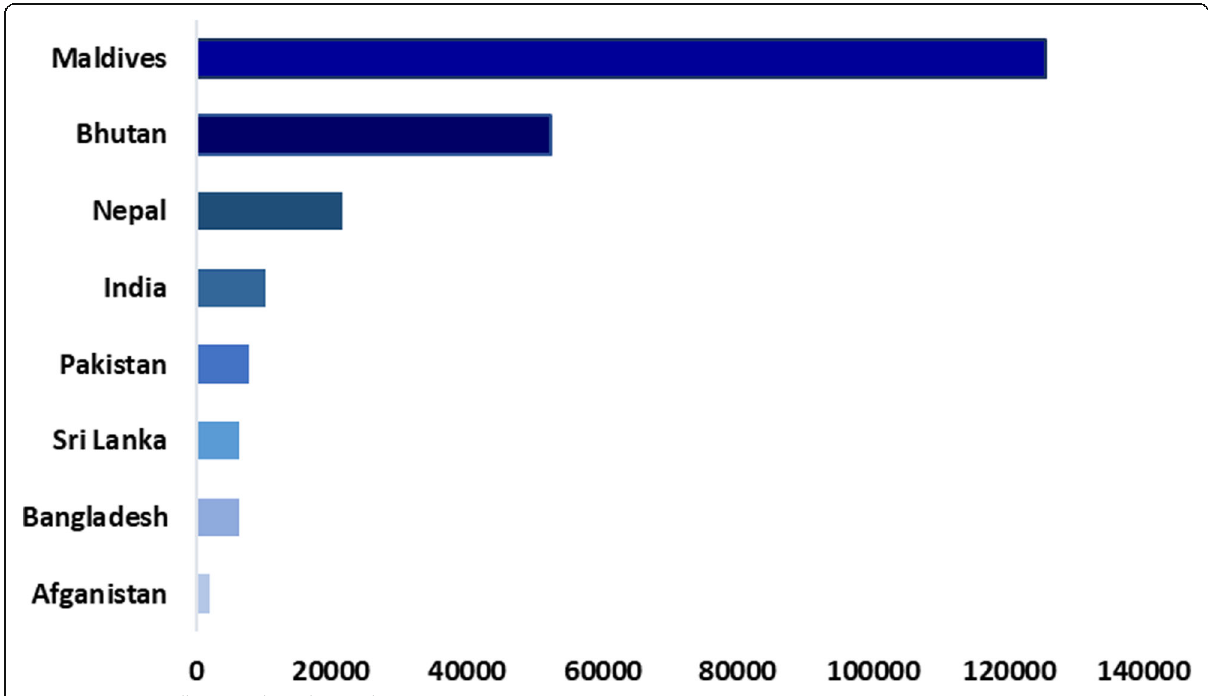
Fig. 5 Test per 1 million people in the South Asian